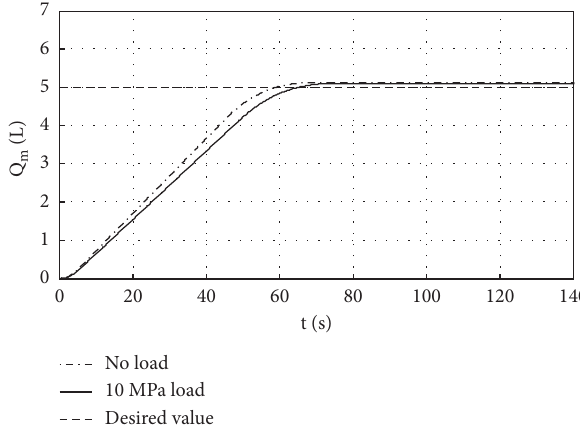
Figure 6: Response curve based on the fuzzy sliding mode